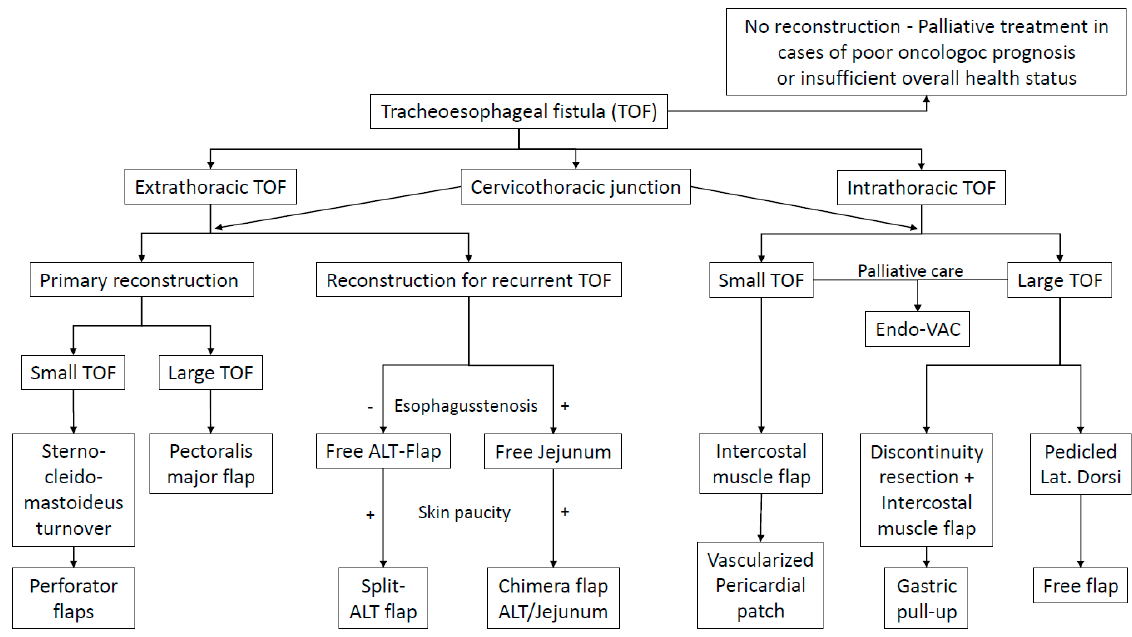
Figure 5. Treatment algorithm for the treatment of patients suffering from tracheoesophageal fistulae.